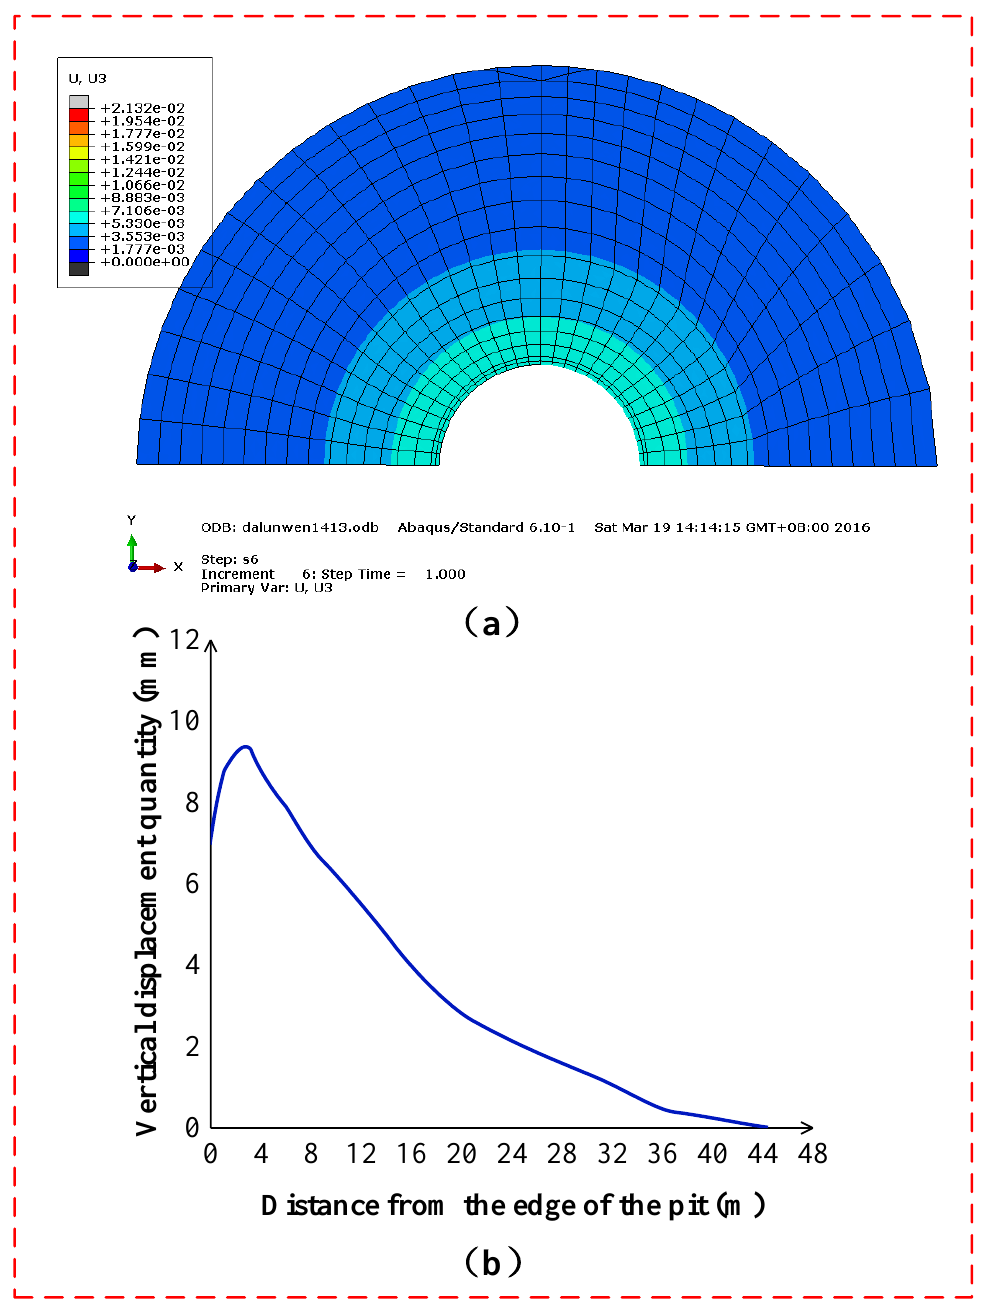
Figure 13. Surface subsidence: ( a ) vertical displacement cloud of the earth ’ s surface; ( b ) surface settlement map.